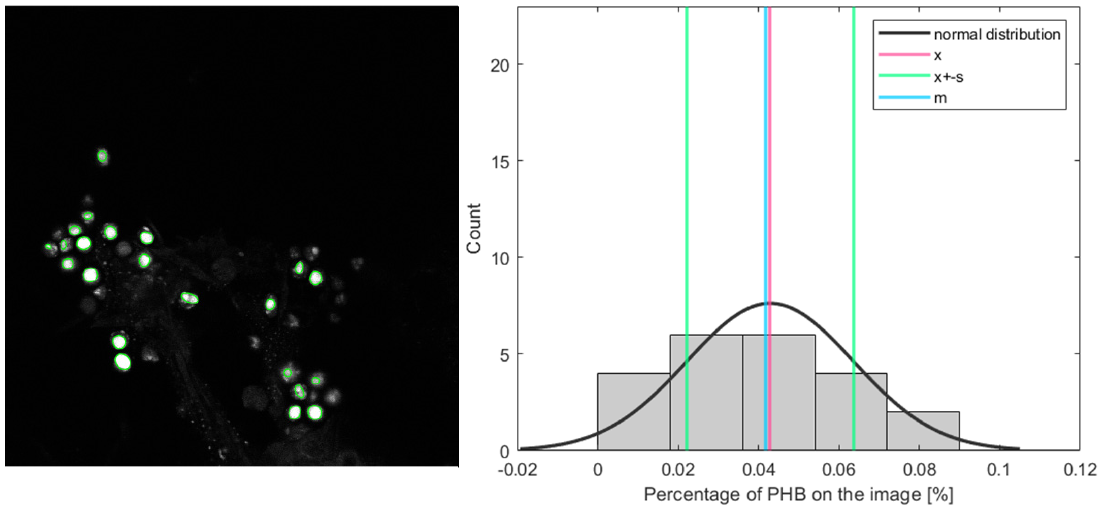
Figure 11. Microscopic image with identified PHB granules ( left ) and histogram showing the percentage of PHB on the microscopic image ( right ), marked with vertical lines: m—median; x—mean; ±s—standard deviation.